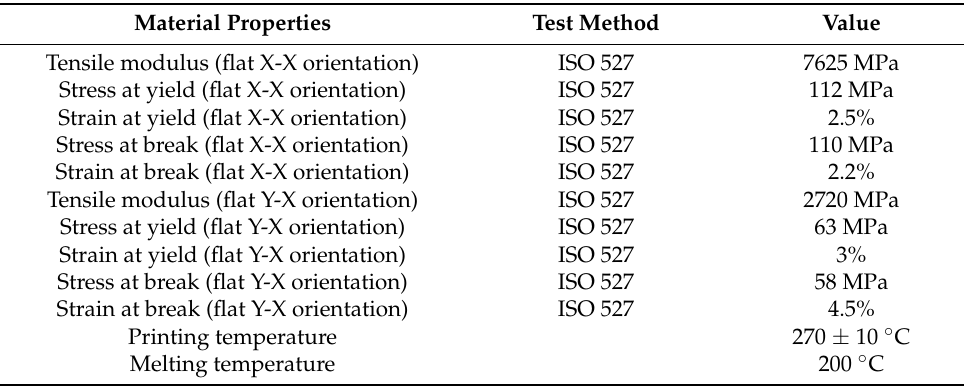
Table 1. Material properties for Novamid ® ID1030 CF10 [30].